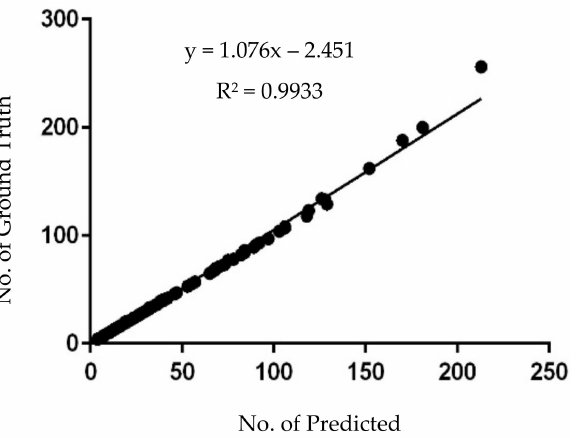
Figure 17. Linear regression between the number of ground truths and the predicted number of shrimps for 100 images in the training dataset for the improved Mask